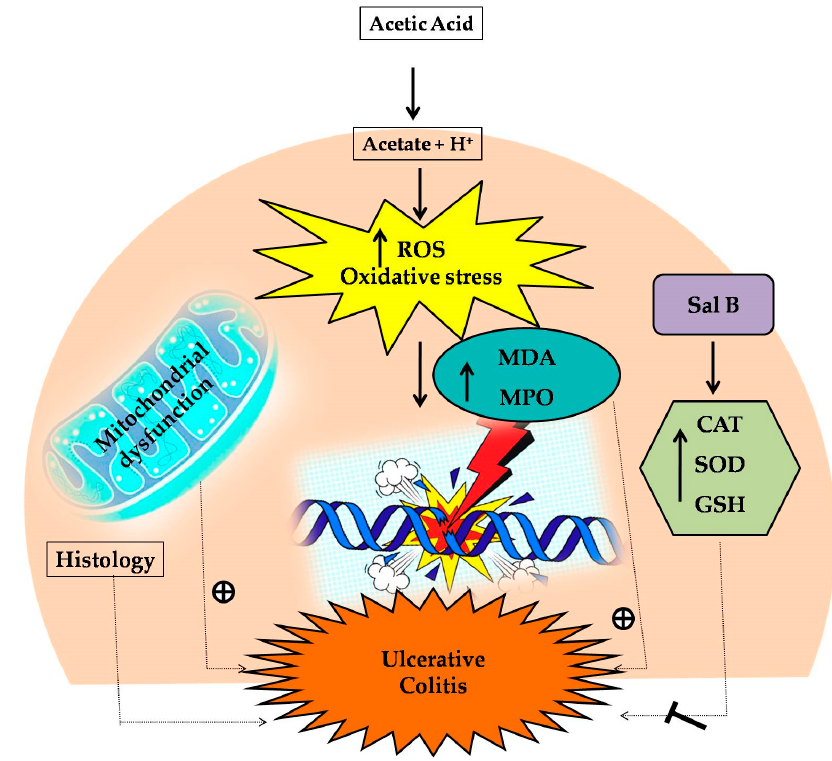
Figure 9. The mechanism of action of Sal B in AA-induced ulcerative colitis.